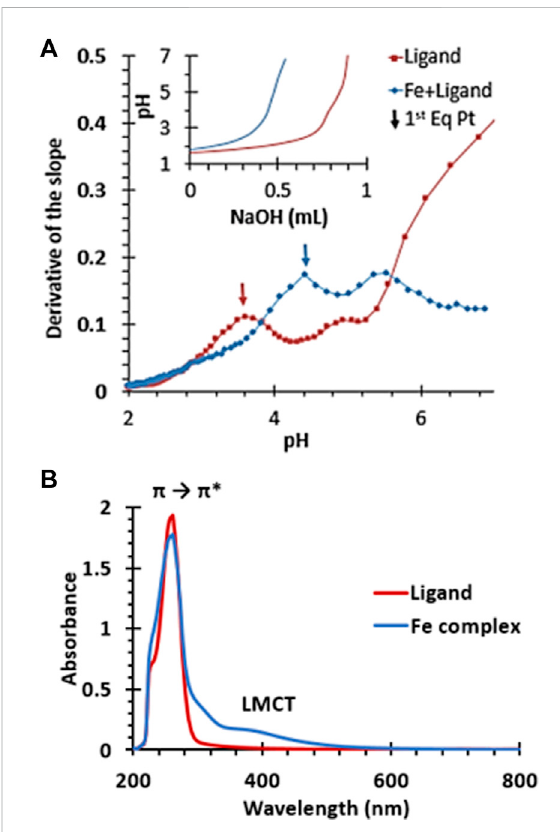
FIGURE 6 (A) First derivative of the potentiometric titration of OH Py 2 N 2 andtheiron(II)complex.Insetshowsoriginaltitrationdata. (B) UV- vis spectra of an aqueous solution of OH Py 2 N 2 (red) and (B) theiron (III) complex of OH Py 2 N 2 .